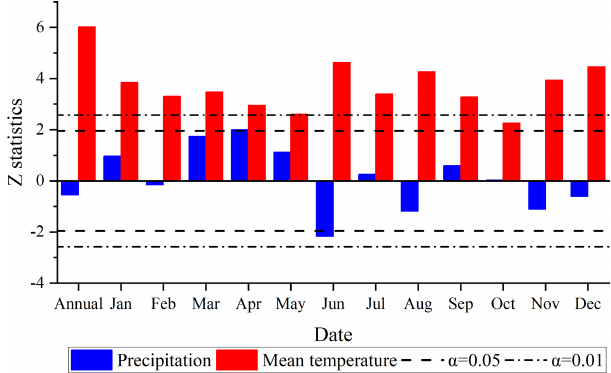
Figure 7. The Mann–Kendall monotonic trend test statistics of the annual and monthly precipitation and mean temperature for the LR basin from 1961 to